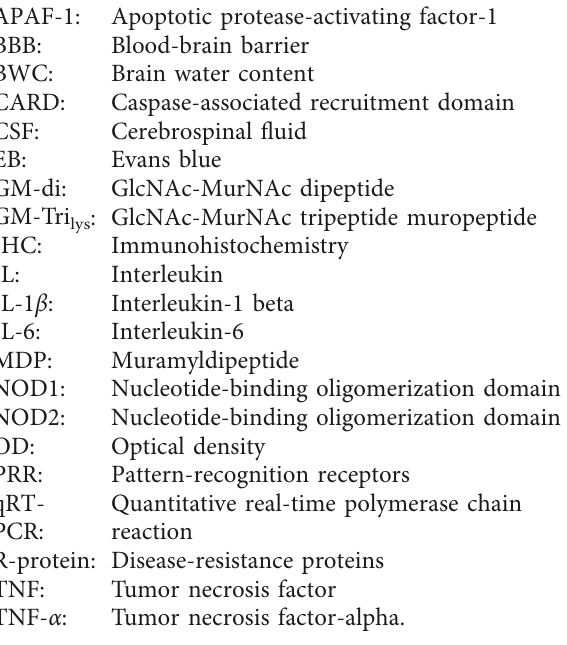
5 in each group). (b) Effect of Streptococcus pneumoniae on BWC. (cid:30) p 0 . 05 compared with control rats’ brains; n ∗∗ <